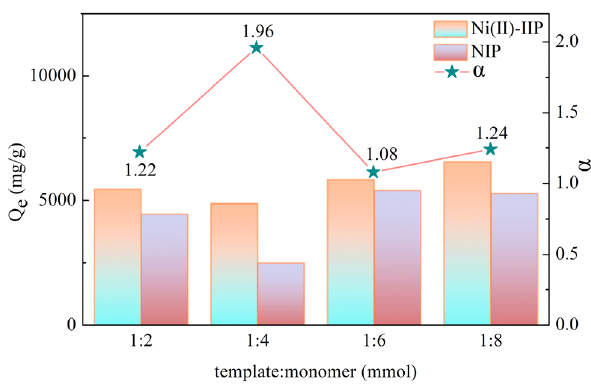
Figure 3: E ff ect of the dosage of functional monomer on adsorption properties.